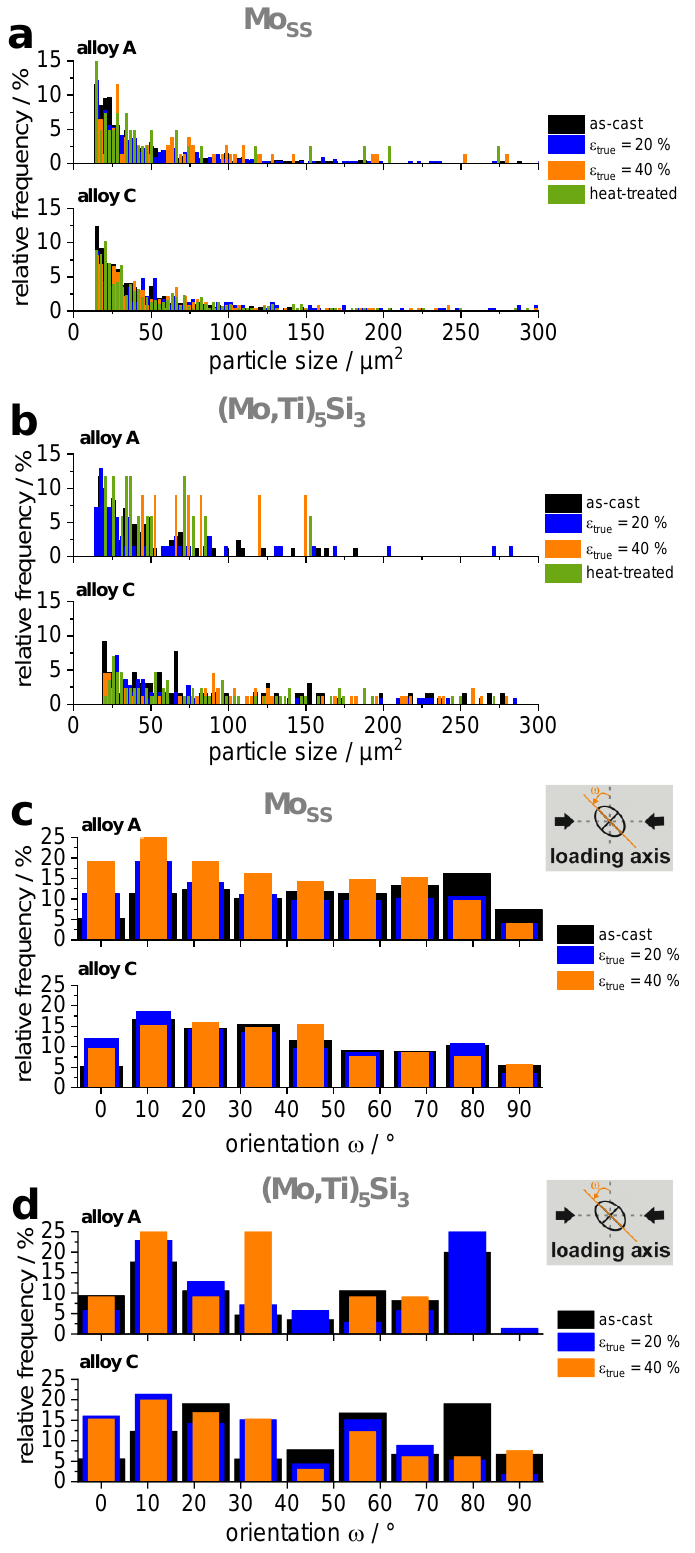
Figure A3. Particle size distribution of Mo SS ( a ) and (Mo,Ti) 5 Si 3 ( b ) particles and their orientation ( c , d ) (particle shape approximated as ellipse) in the alloys A and C in as-cast condition and after compressive creep testing at 1200 °C, 200 MPa up to a true strain of 20 and 40% in comparison to heat-treated samples at 1200 °C for 100 h.